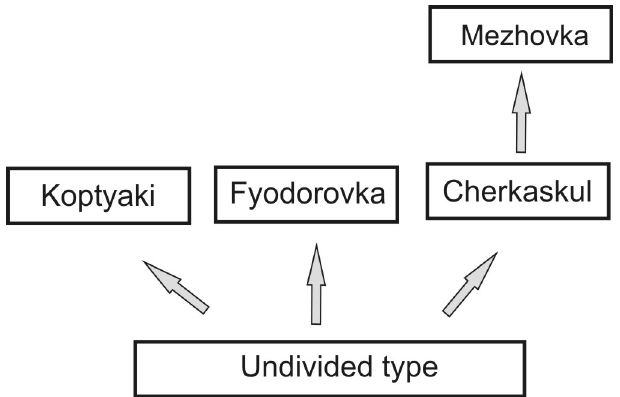
Figure 22: Scheme of Cherkaskul cultural genesis of M.F. Obydenov and A.F. Shorin